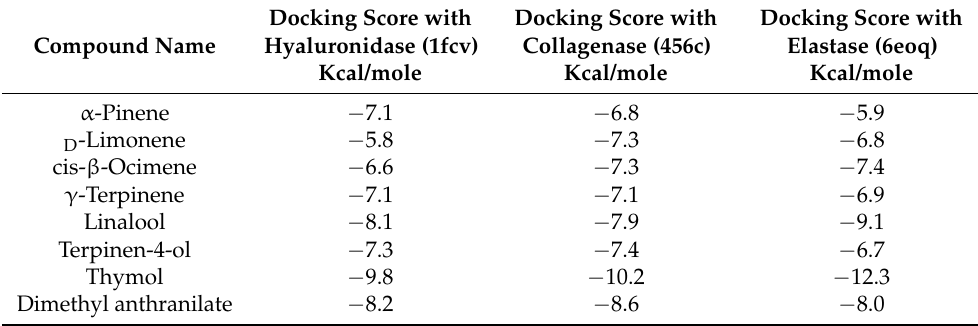
Table 3. Docking score of major compounds of C. reticulata cultivars with hyaluronidase, collagenase, and elastase binding